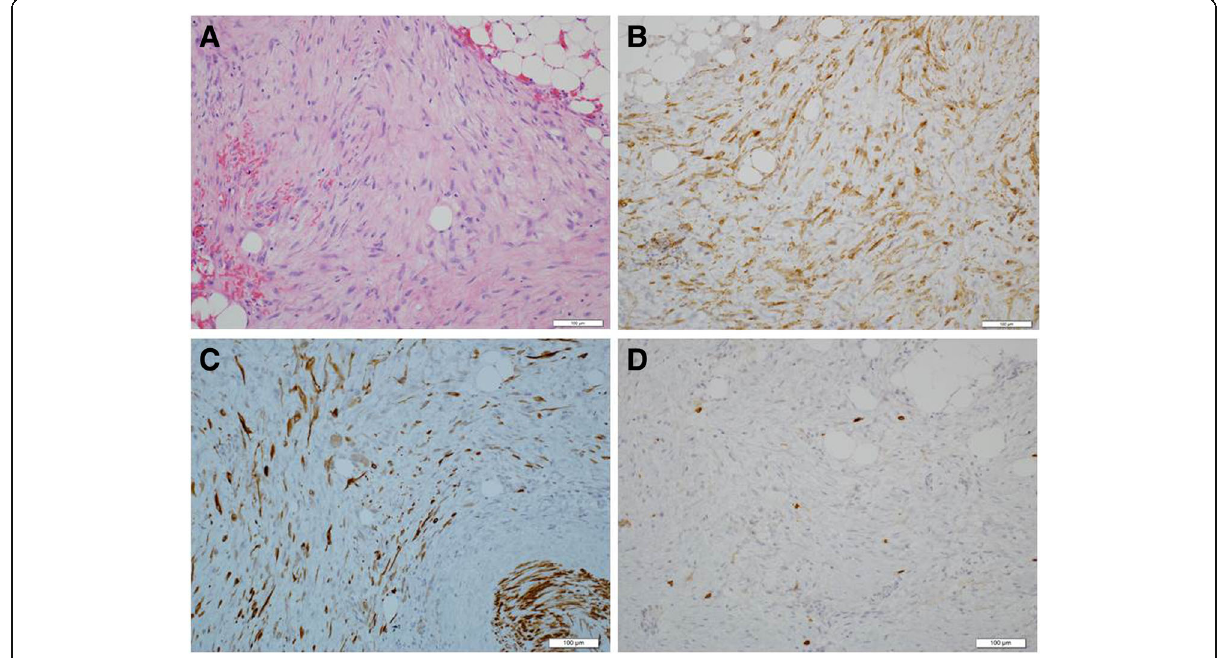
Fig. 3 Pathological findings of the resected specimen. a In hematoxylin-eosin staining, the tumor consisted of relatively homogenous spindle cells with few mitoses (< 1%). b Both the cytoplasm and nucleus were positive in β -catenin staining. c In desmin staining, vascular smooth muscles were positive whereas tumor cells were marginally positive. d In c-kit staining, only mast cells were